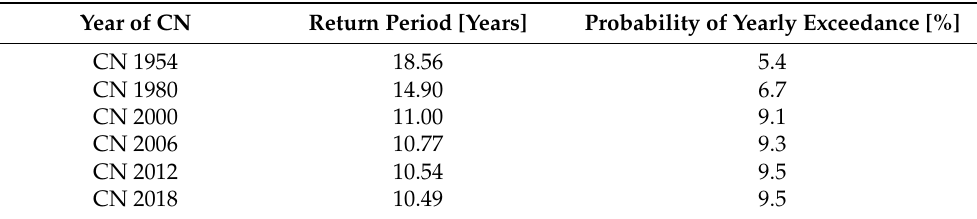
Table 3. Return period and probability of yearly exceedance the second warning threshold of 90 m 3 /s at given CN conditions.